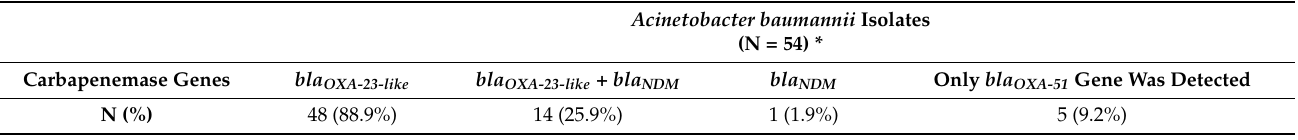
Table 1. Mechanism of carbapenem resistance among carbapenem resistant Acinetobacter baumannii (CRAB) isolates from ICU patients with pneumonia.